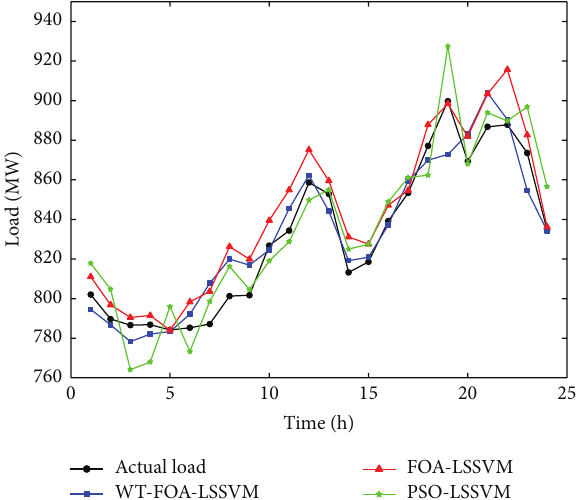
Figure 7: Actual load and forecasting results of WT-FOA-LSSVM, FOA-LSSVM, and